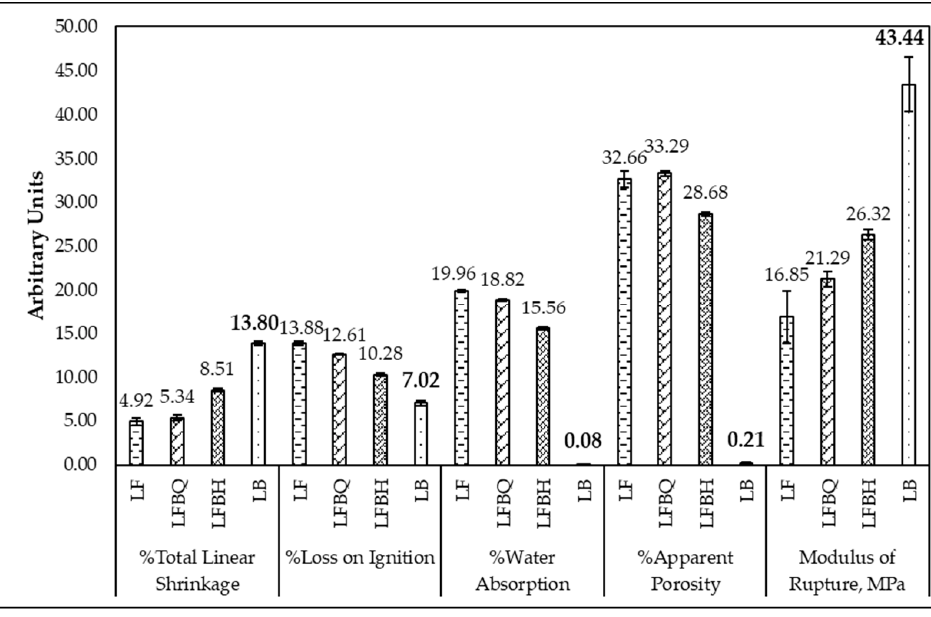
Figure 6. Physical and mechanical properties of tiles fired at 1200 °C.